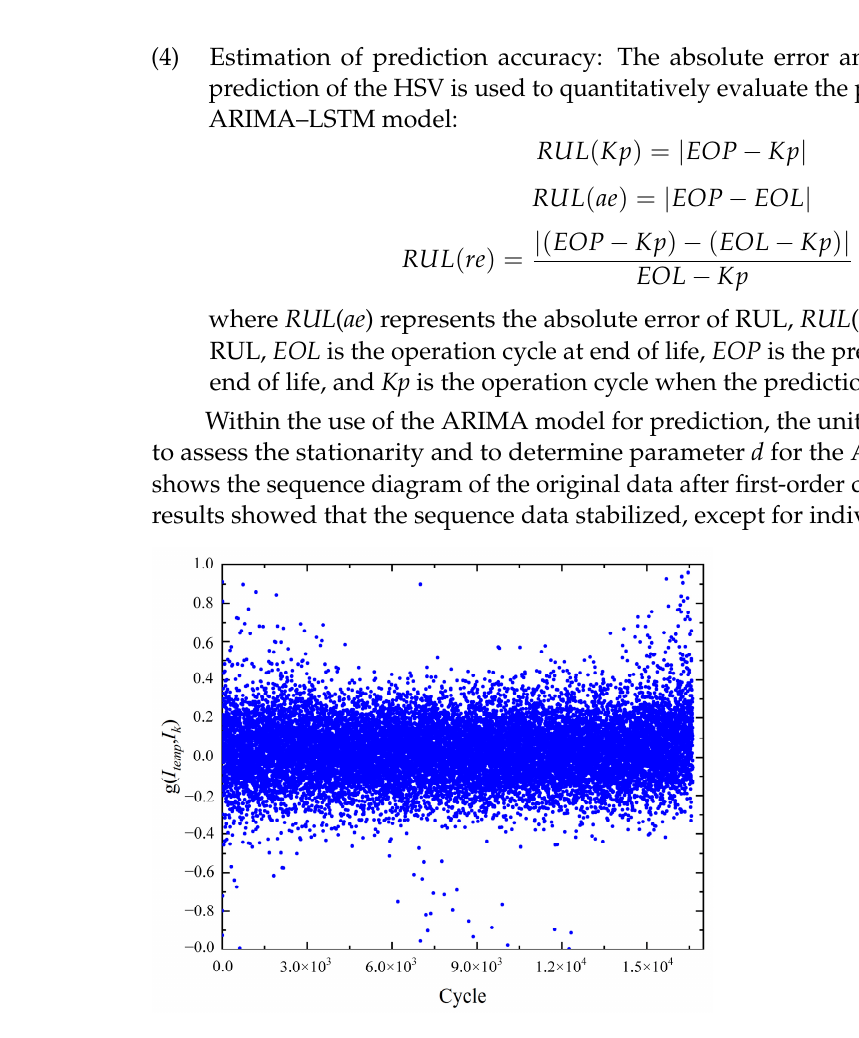
Figure 11. Sequence diagram after first ‐ order difference processing.